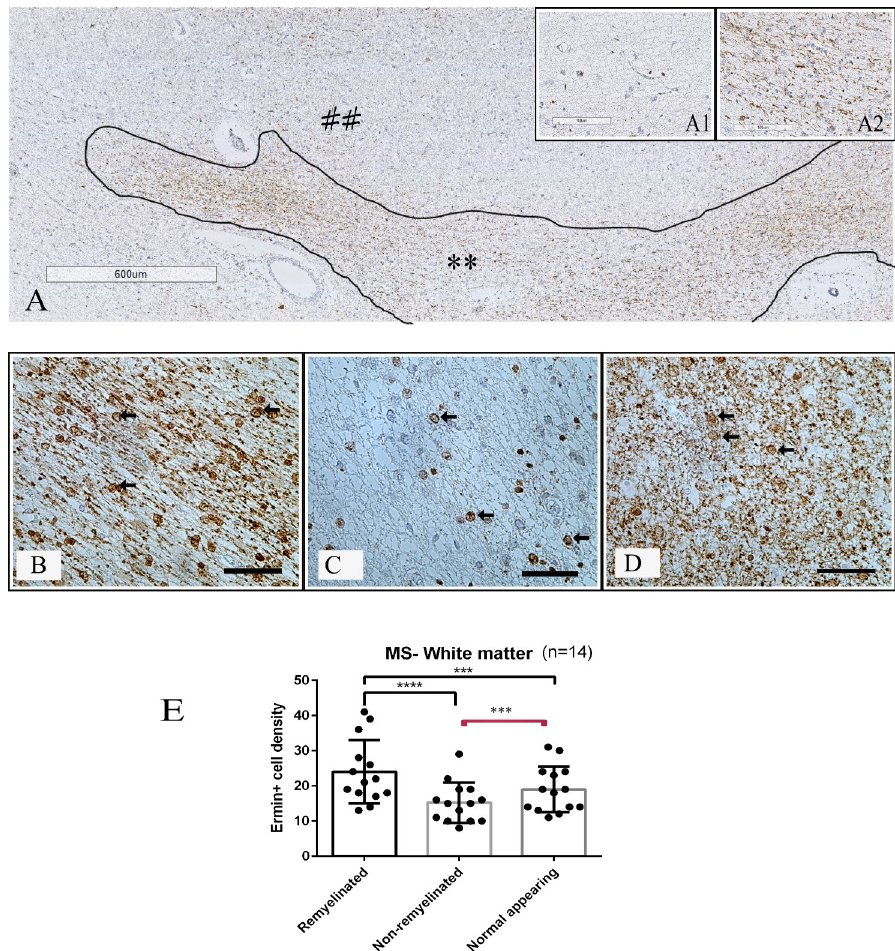
Fig 3. Ermin positive cell density in MS white matter lesions. (A) Myelin proteolipid protein (PLP) stained tissue section ( �� represents remyelinated white matter area and demyelinated white matter area is represented by ##); insertion A1 shows a demyelinated area with no remyelination, and insertion (A2) shows a partly remyelinated area. (B-D) Single-labelling immunohistochemistry for ermin in remyelinated (B) and non-remyelinated (C) lesion areas, and in normal-appearing (D) white matter tissue from MS brain. Immunopositive cells have the morphology of oligodendrocytes (arrows). (E) Density of ermin+ cells in remyelinated, non-remyelinated and normal-appearing regions in white matter. Scale bar = 50 μ m, ���� : p < 0.00001, ��� : p < 0.0001.